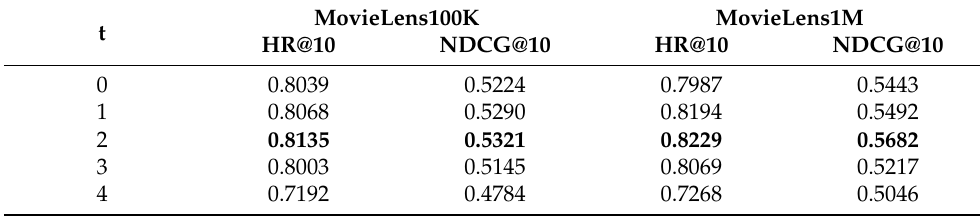
Table 3. The impact of the depth of attention layer.